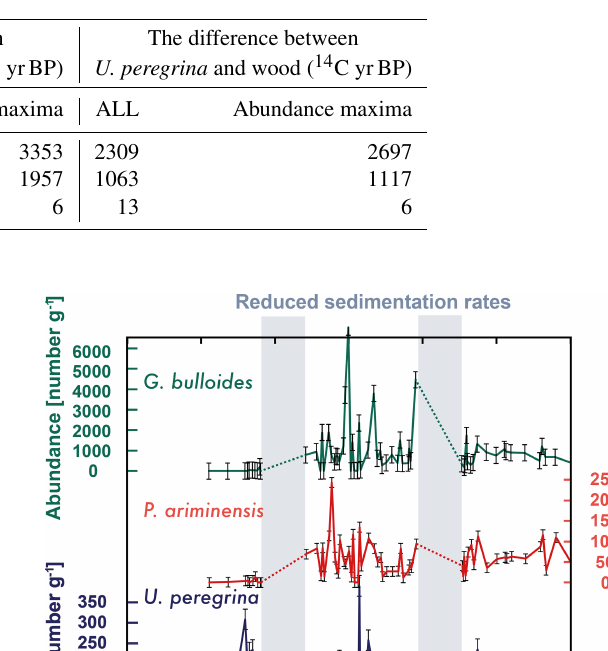
Table 2. The difference between benthic foraminifera and concurrent wood 14 C ages for all measurements (ALL) and only at abundance maxima (see Fig. 4).